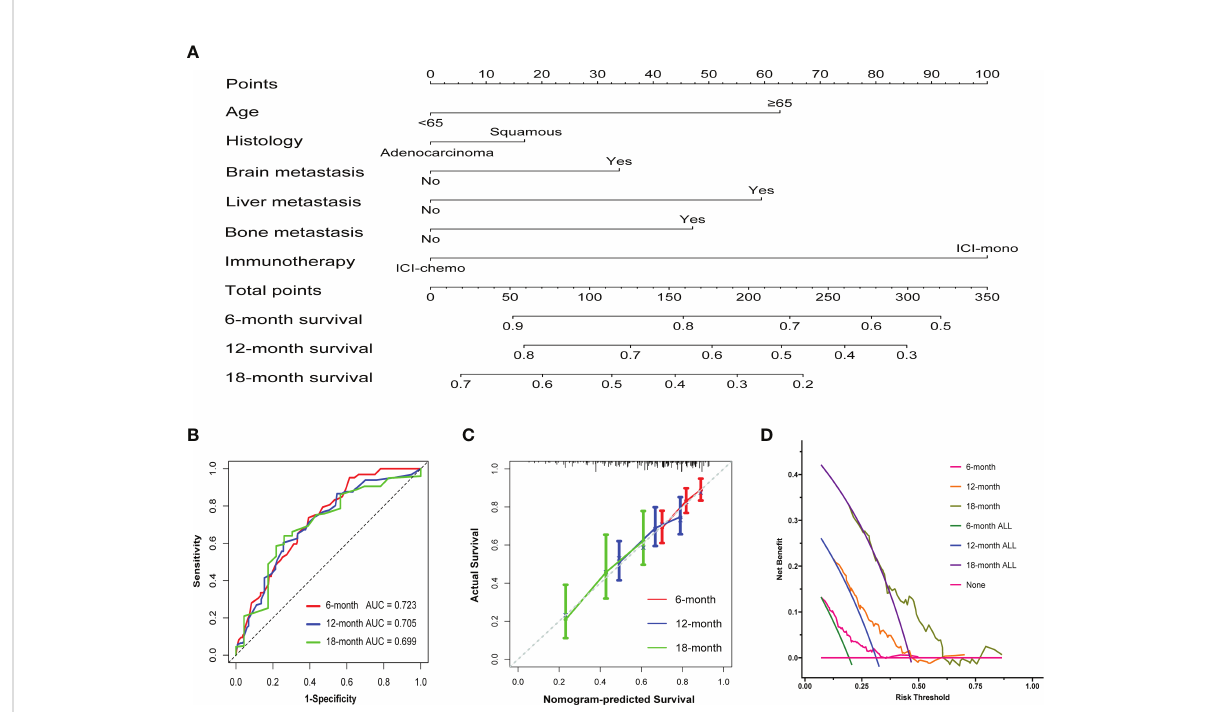
FIGURE 5 Construction of the nomogram system in patients after propensity score matching. (A) Nomogram predicting 6-, 12-, and 18-month overall survival for patients in the matched cohort. A total point was calculated by adding up the scores achieved for each factor. (B) ROC curves of the nomogram. (C) Calibration curves of the nomogram between predicted and observed 6-, 12-, and 18-month overall survival. The dashed line of 45° represents the perfect prediction of the nomogram. (D) Decision curve analysis for the nomogram. The red line at the bottom of the picture represents the assumption that no patients died at 6, 12 or 18